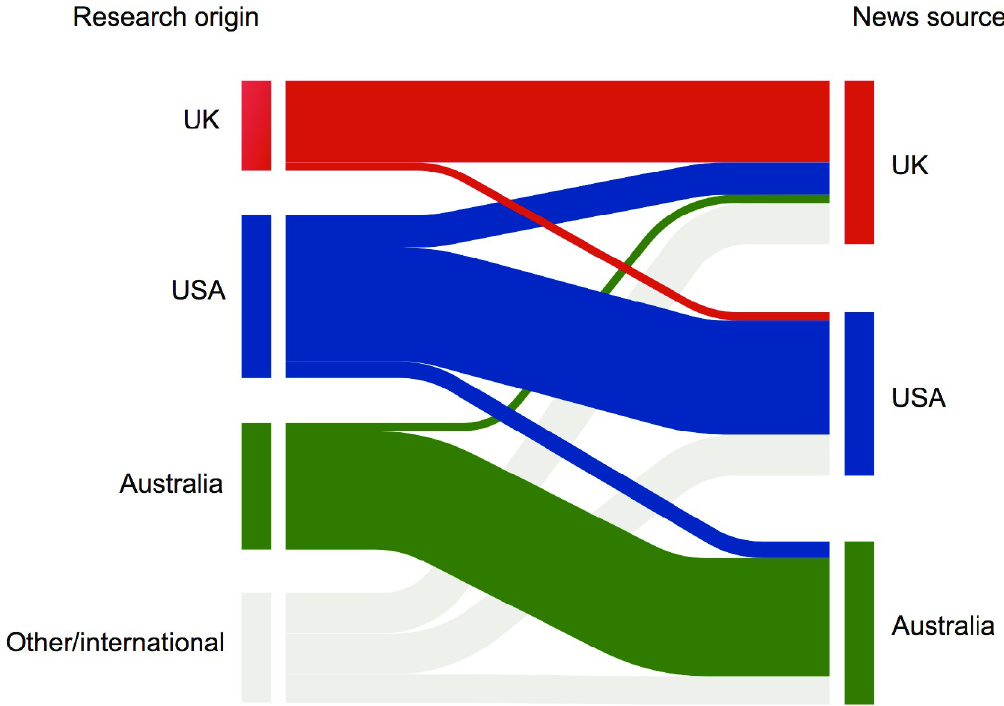
Fig 4. National bias in reporting of cancer research. Sankey chart showing relationships between country of research origin (left) to country in which reporting news organisation is based (right), with bar sizes representing proportional representation. The UK is represented by The Guardian , USA by NY Times and Australia by SMH and ABC . Designation of research source as “other/international” refers to studies where the primary authors were based in countries other than the UK, Australia or